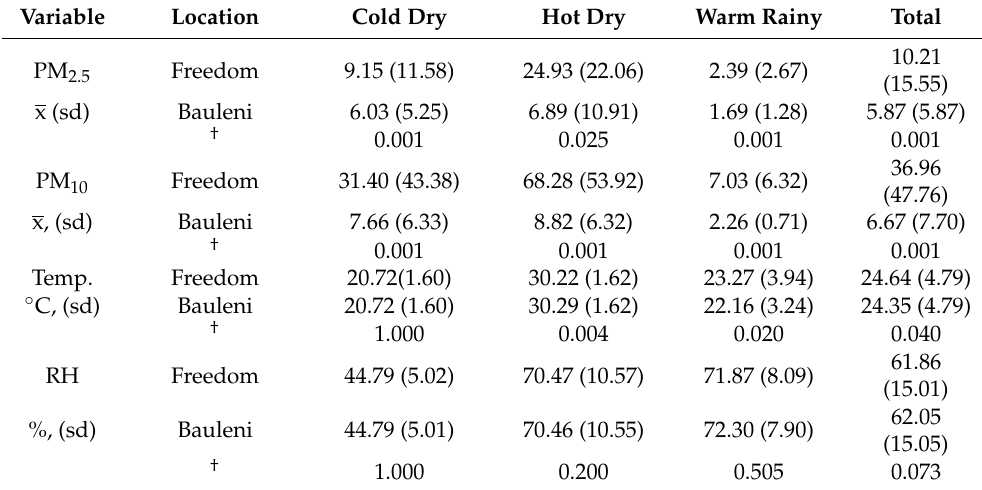
Table 2. Mean concentration ( µ g/m 3 ) of particulate matter and meteorological variables for the exposed and control communities.